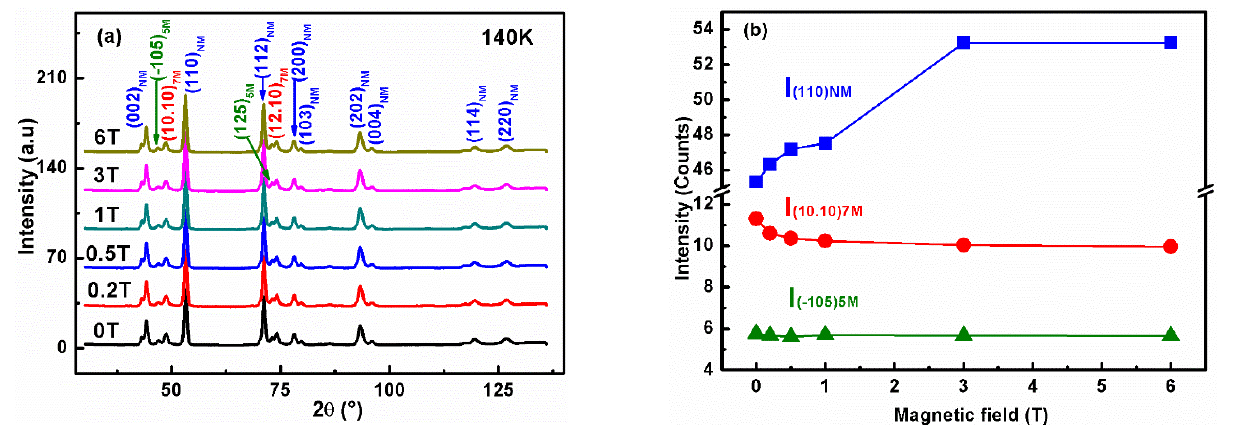
Figure 11. HEXRD patterns at different magnetic field levels in the 2 θ range from 30 ◦ to 140 ◦ for the Ga22-4 ( x = 5.5) alloy ( a ). Evolution of HEXRD patterns as a function of applied magnetic field ( b ).